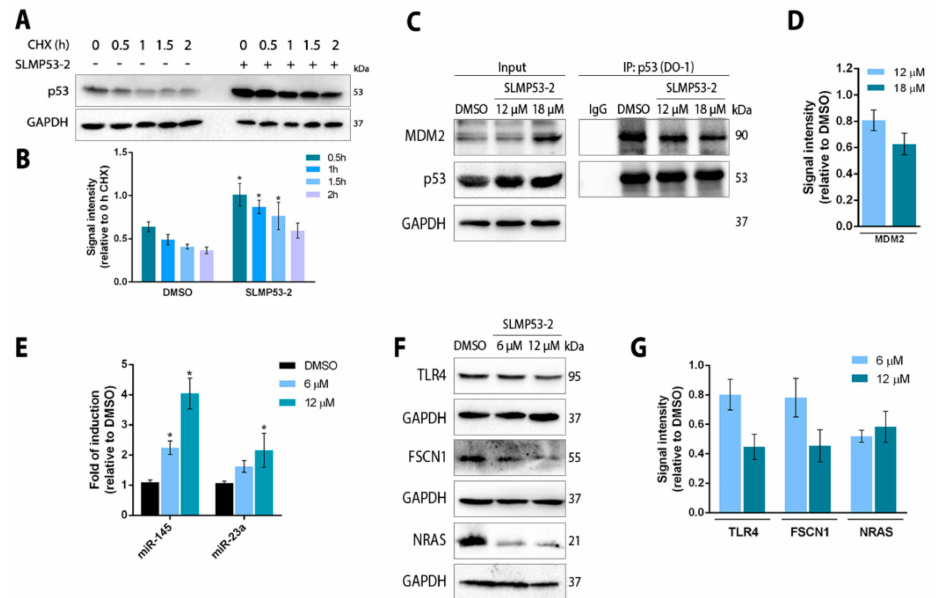
Figure 3. SLMP53-2 enhances p53 stabilization by disrupting the p53–MDM2 interaction and interferes with the miRNA network in melanoma cells. ( A ) p53 protein levels in A375 melanoma cells treated for 24 h with 12 µ M SLMP53-2 or solvent followed by cycloheximide treatment from 0 to 2 h (CHX; 150 µ g/mL). ( B ) Quantification of p53 protein expression levels; immunoblots are representative of five independent experiments; GAPDH was used as loading control. Values for cells nontreated with cycloheximide (0 h) were set as 1; data are mean ± SEM, n = 5. ( C , D ) Coimmunoprecipitation (Co-IP) was performed in A375 cells treated with SLMP53-2 for 4 h. In C, representative immunoblots of five independent experiments are shown—whole-cell lysate (Input). p53 from IP was used as loading control. In D, quantification of protein expression levels relative to DMSO is shown (set as 1). Data shown are mean ± SEM, n = 5. ( E ) Expression levels of miR-145 and miR-23a in A375 cells after 24 h of treatment with SLMP53-2 were determined by RT-qPCR; fold of change is relative to DMSO; data are mean ± SEM, n = 5; values are significantly different from DMSO: * p < 0.05, one-way ANOVA followed by Tukey’s test. ( F , G ) Protein levels of miR-145 target genes, in A375 cells treated with SLMP53-2 for 24 h. In ( F ), immunoblots are representative of five independent experiments; GAPDH was used as loading control. In ( G ), quantification of protein expression levels is shown; values with DMSO were set as 1; data are mean ± SEM, n =